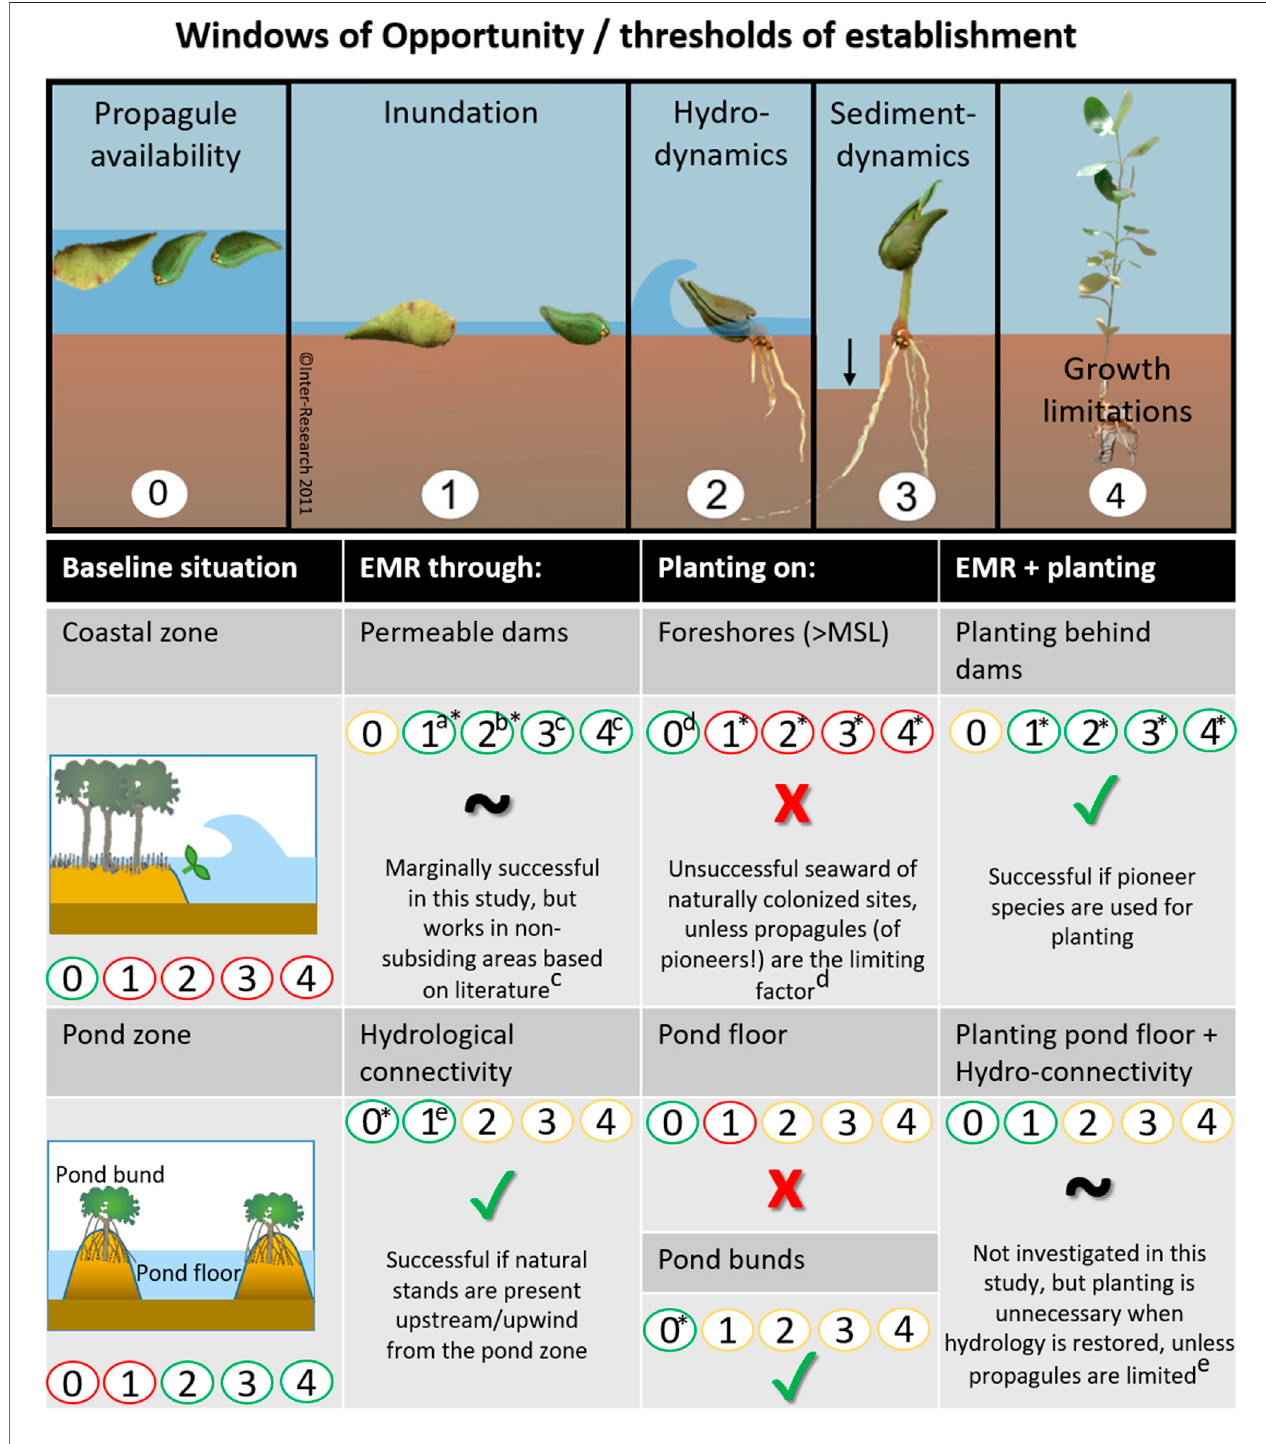
FIGURE 8 | Summary of the effectiveness of different restoration methods (EMR, planting, and a combination of both) to overcome thresholds of establishment in the coastal zone and the pond zone (red: ineffective, green: effective, yellow: condition already met in baseline situation), based on the fi ndings of this study (*) and literature [a: (Cado et al., 2021), b: (Winterwerp et al., 2020), c: (Van Cuong et al., 2015), d: (Saenger and Siddiqi, 1993), e: e.g. (Lewis, 2005; Matsui et al., 2010; Proisy et al., 2018; van Bijsterveldt et al., 2020)]. The top panel of this fi gure was expanded from Balke et al. (2011) ’ s original Windows of Opportunity fi gure (panel 1-3).